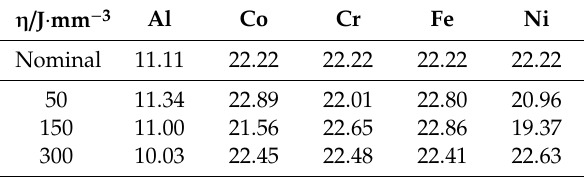
Figure 9. The relationship between energy density and relative density of the SLM specimens. Table 2. Chemical composition of the SLM samples under different energy densities (at.%).